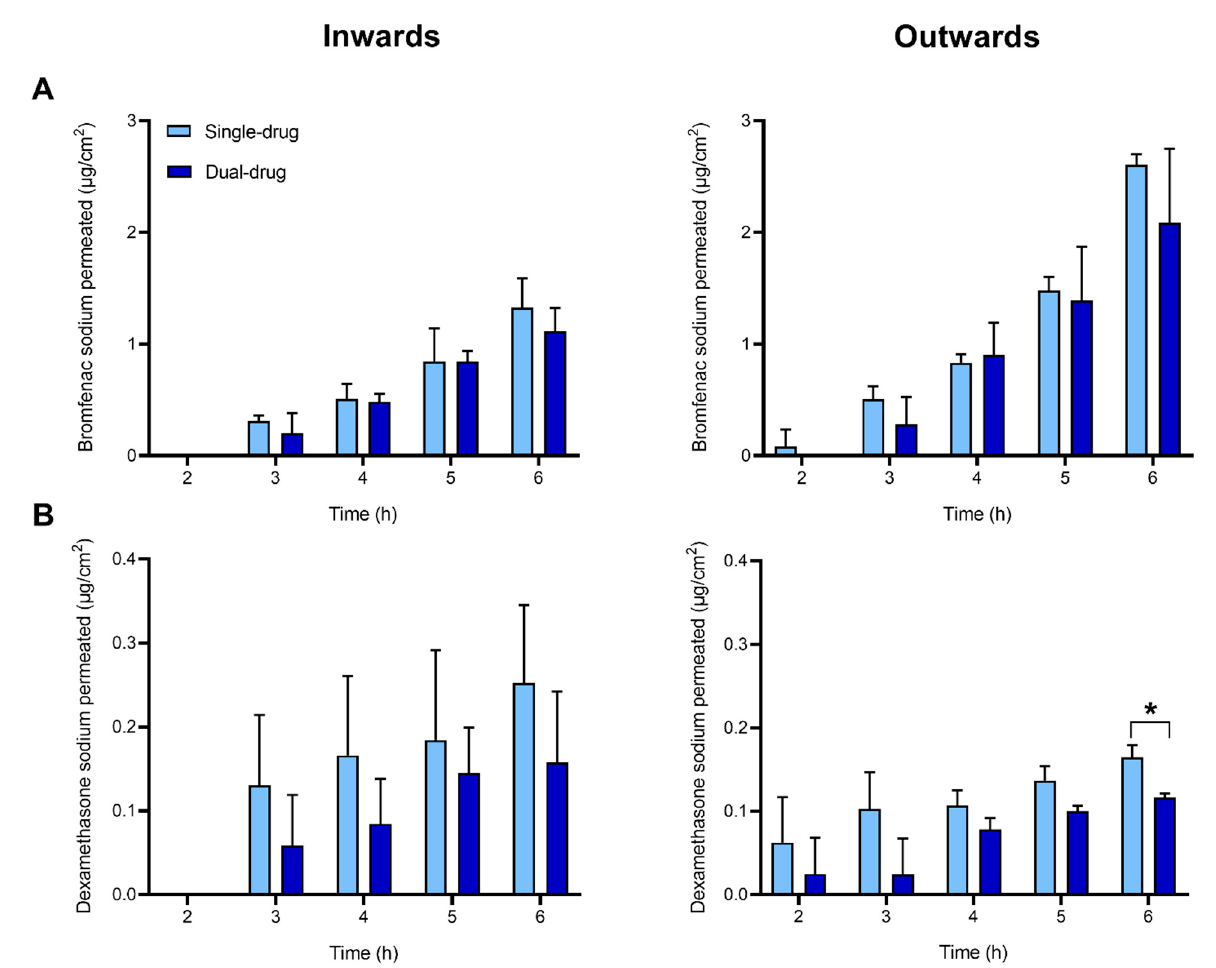
Figure 4. Cumulative amount of drug permeated through the cornea over time: bromfenac sodium ( A ) and dexamethasone sodium ( B ). Single- or dual-drug solutions with 125 µg/mL of each drug were placed in the donor chamber. Experiments were conducted in inward (left column) or outward (right column) flux direction through the cornea. Mean values and standard deviations ( n = 3); * t -test; p < 0.05. Table 1. Cumulative mass permeated after 6 h, lag-time (t lag ), steady state flux (J) and permeability coefficient (P coeff ) of the drugs when tested as a single-drug solution (Single) or dual-drug solution (Dual).